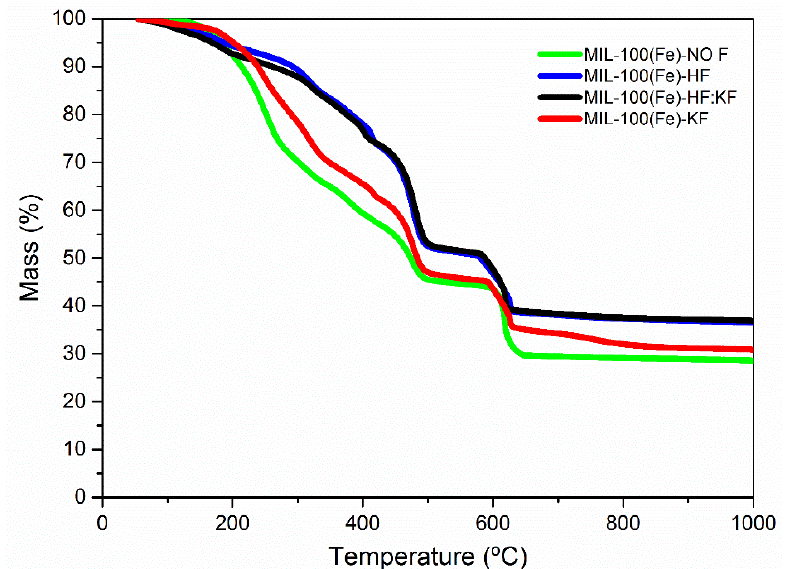
Figure 4. Thermogram of MIL-100(Fe) synthesized.